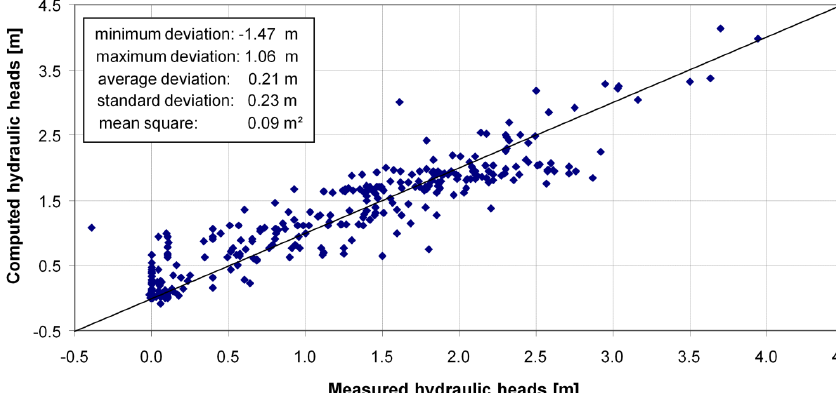
Fig. 10. Statistical results for the hydraulic calibration. Figure 10. Statistical results for the hydraulic calibration. 2